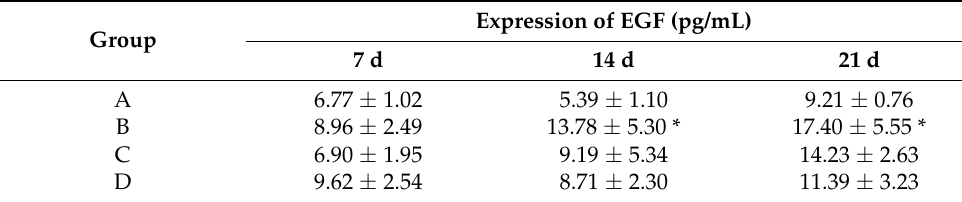
Table 3. Expression of EGF in the granulation tissue of rats at the different stages (x ± s).